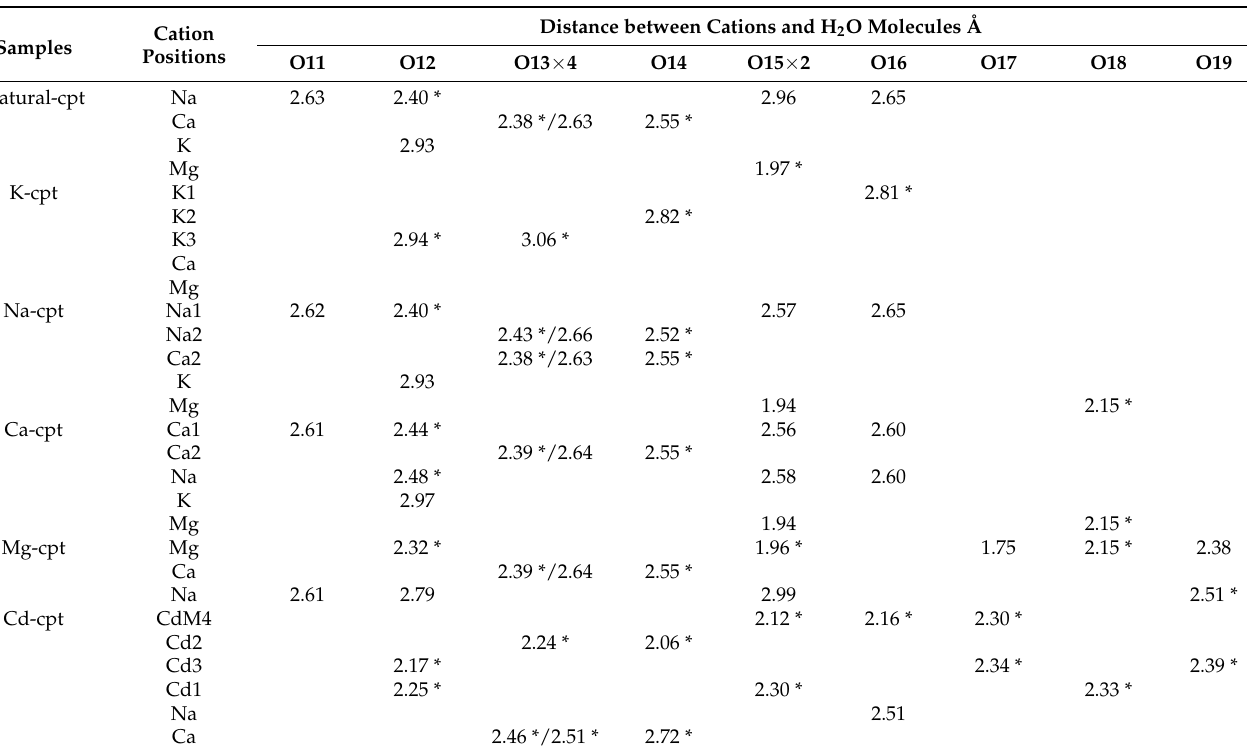
Table 6. Distance between cations and H 2 O molecules (values marked with (*) are the closest distances between the cations and H 2 O